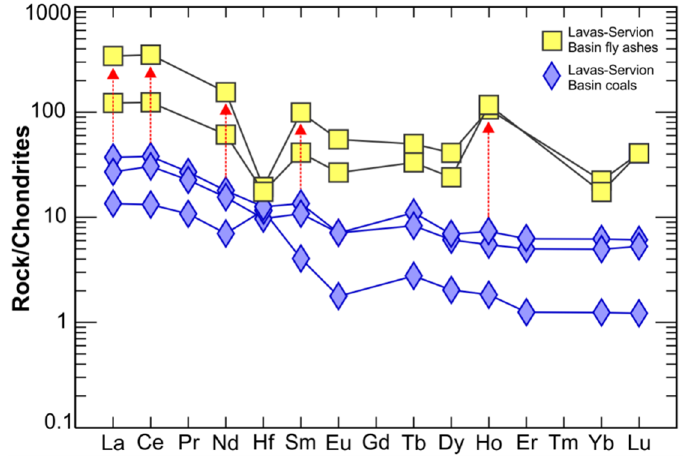
Figure 4. Chondrite normalized-REE patterns (Normalization factors from McDonough and Sun, [31]) from coal samples from Lavas-Servion and Ptolemais basins.